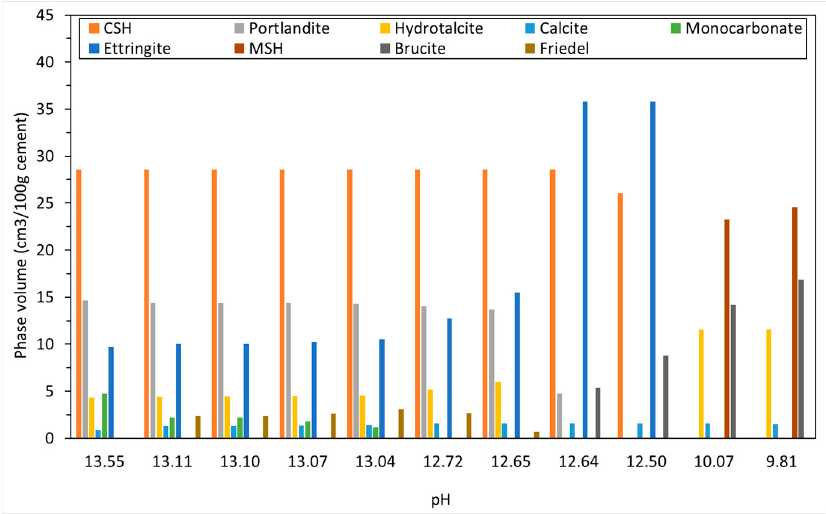
Figure 12. Change in solid phase volume with pH with increasing seawater ingress.